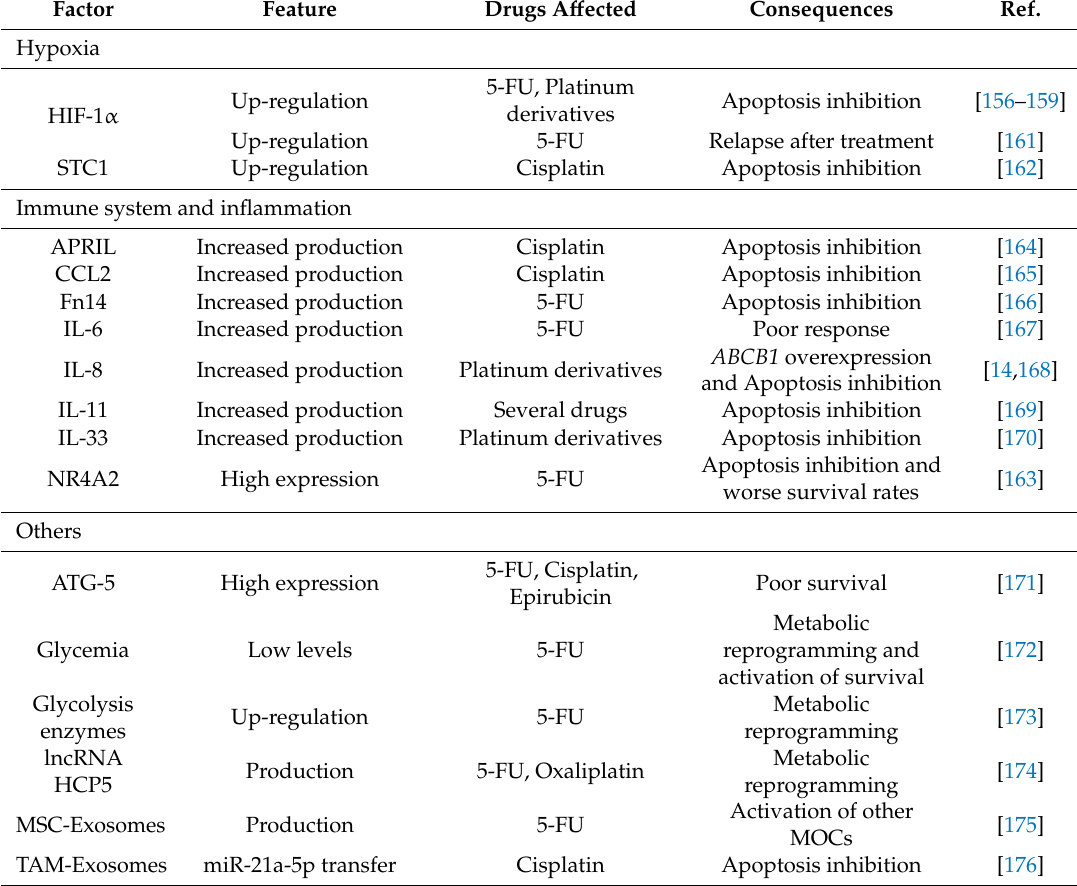
Table 6. Mechanisms of chemoresistance type 6 (MOC-6) to drugs used in the treatment of GAC. Factor Feature Drugs A ff ected Consequences